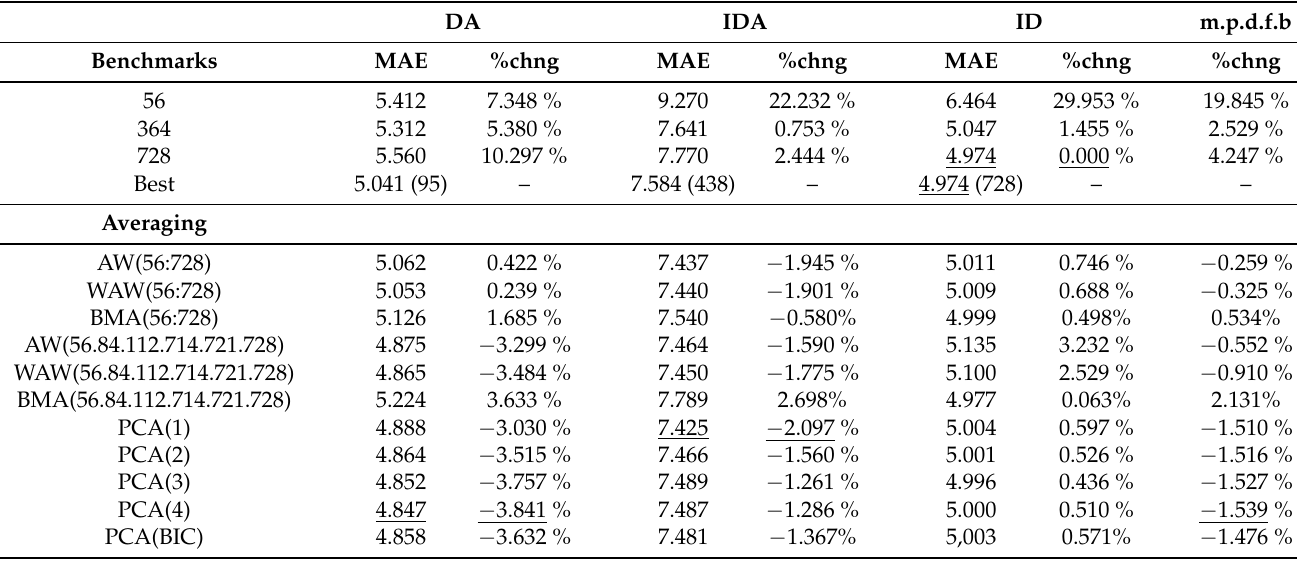
Table 2. Mean absolute errors (MAE) and mean percentage deviation from the best benchmark (m.p.d.f.b) of the forecast obtained with all three considered models in the 778-days out-of-sample period from 26 June 2017 to 15 August 2019. In the first four rows reported result for models calibrated on single in-sample length, whereas the bottom rows correspond to models using one of the averaging techniques. The percentage change compared to the best ex–post length of calibration window is reported in columns %chng. Note that the best model in terms of MAE is